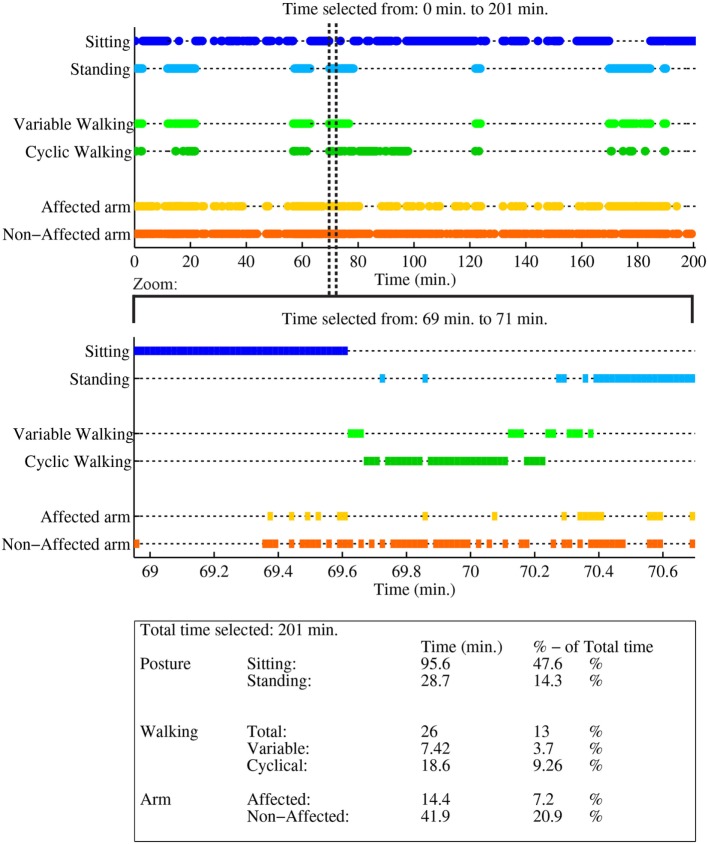
Case report example page 1: activity monitor, as reported in van Meulen et al. (2016).